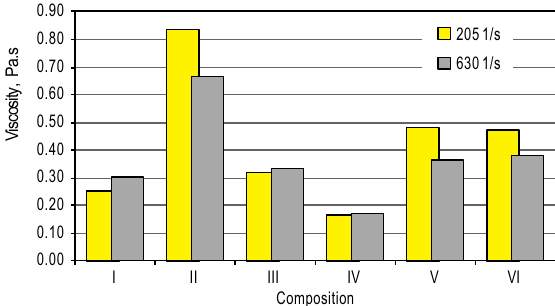
Fig. 4. Dependence of the viscosity of Portland cement pastes on different modifiers at the shear rates of 205 s –1 and 630 s –1